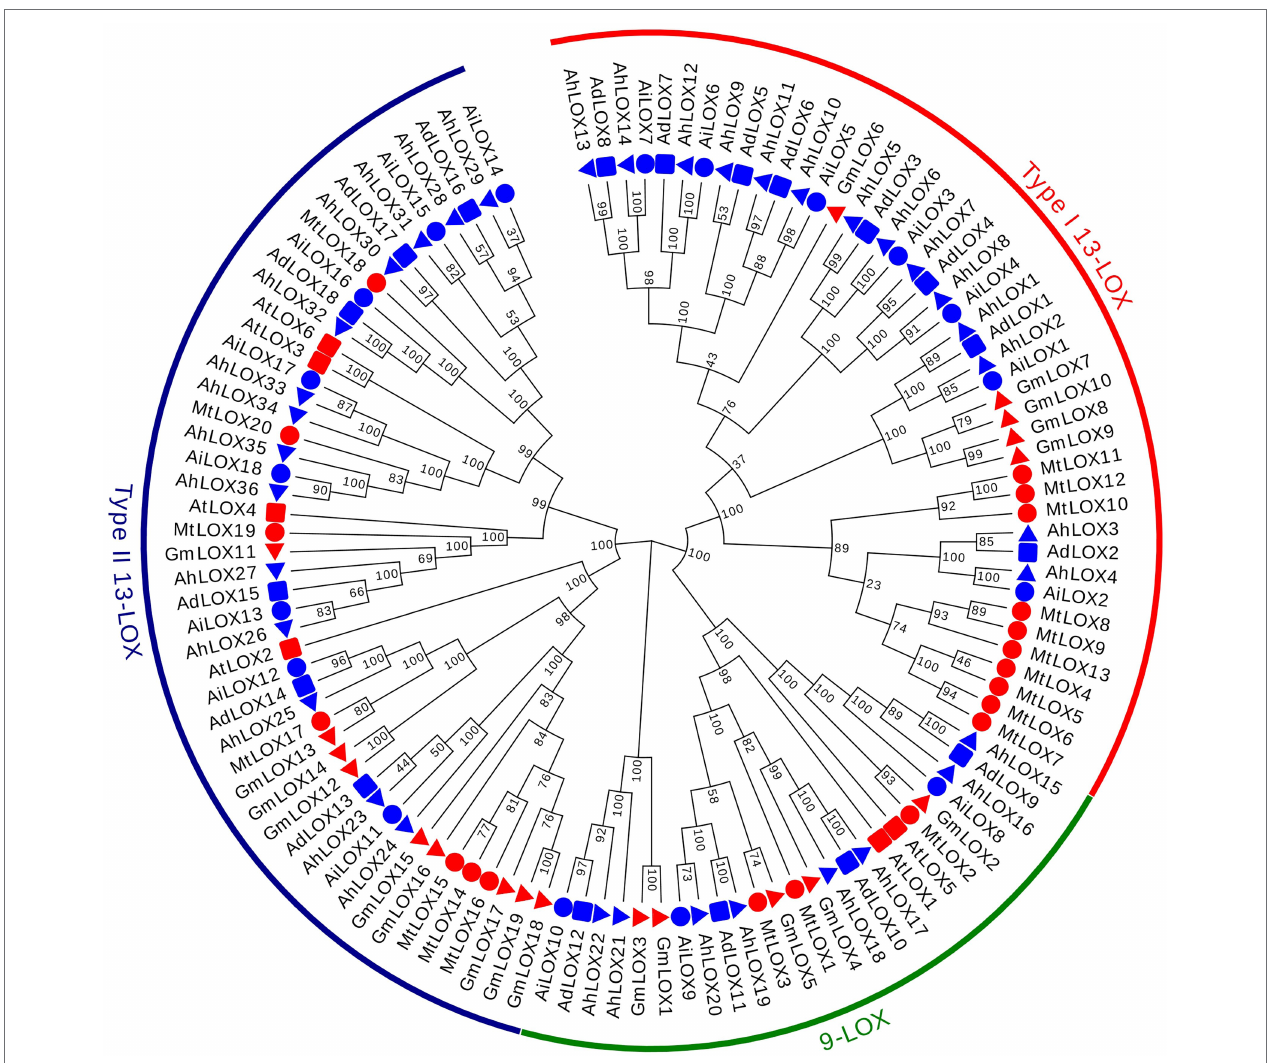
FIGURE 2 | Phylogenetic tree of the peanut LOX gene family. Phylogenetic tree of 117 LOX proteins from peanut (72), Arabidopsis (6), Glycine max (19) and Medicago truncatula (20). MEGA X software was used to construct the maximum-likelihood (ML) phylogenetic tree with 1,000